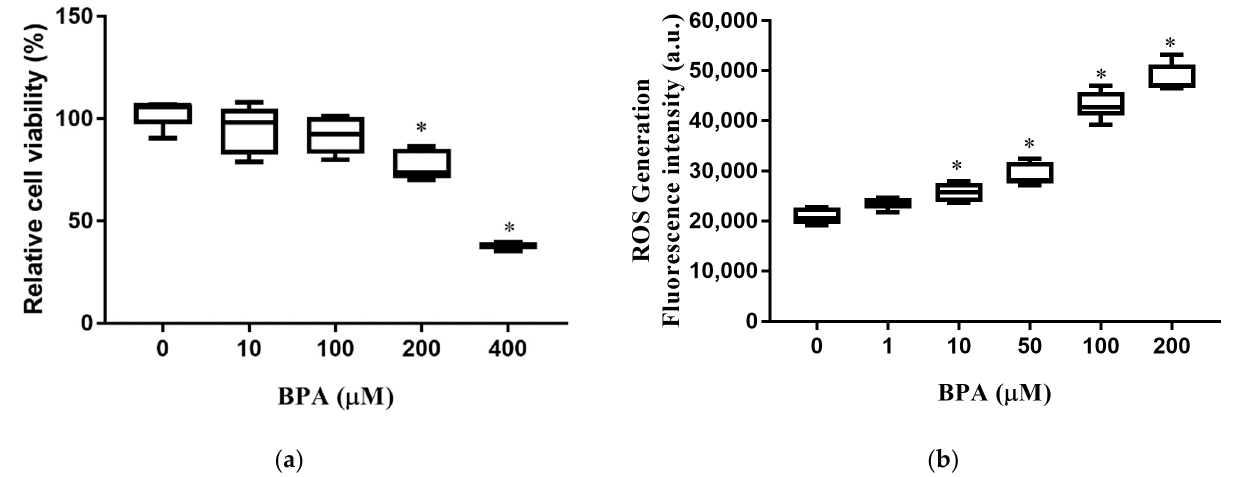
Figure 1. BPA-induced cytotoxicity and ROS production: ( a ) Cells were incubated at different concentrations of BPA for 24 h. Cell viability was measured using an MTT assay; ( b ) cells were pretreated with 2 ′ , 7 ′ -dichlorofluorescin diacetate for 45 min and loaded with BPA for 6 h. Intracellular ROS levels were determined according to fluorescence intensity. The boxplots present the median (central horizontal line), 25th and 75th quartiles (upper and lower limits of the box), and the maxi- mum and minimum range values (error bars). The results are expressed as the mean ± SD of six independent experiments. * p < 0.05 vs. control (without BPA) group.